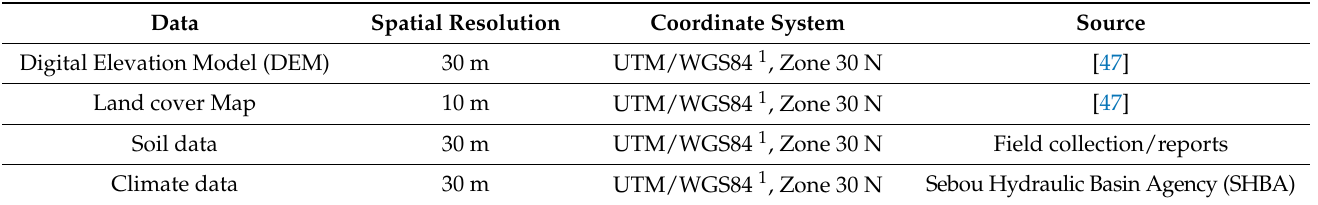
Table 1. Data used in this